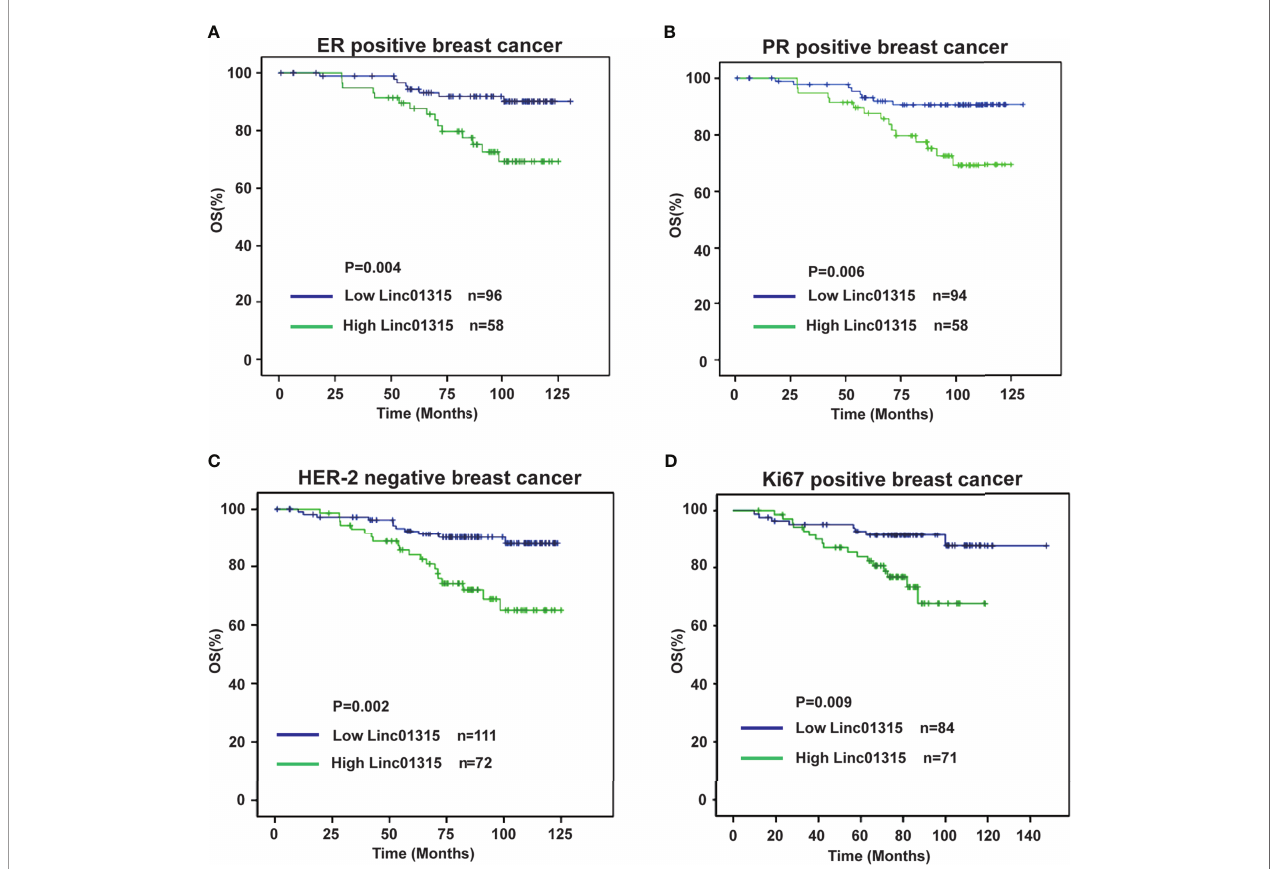
FIGURE 4 | Overall survival curves according to breast cancer patients ’ clinic pathological features and Linc01315 expression level. (A) OS curve of ER positive patients based on the level of Linc01315. (B) OS curve of PR positive patients based on the level of Linc01315. (C) OS curve of Her-2 negative patients based on the level of Linc01315. (D) OS curve of Ki67 positive patients based on the level of Linc01315.